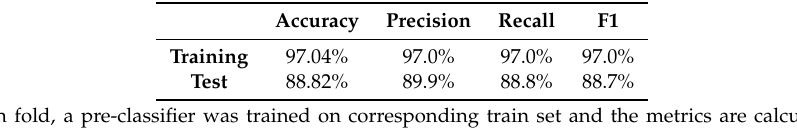
Table 1. The performance results of the classification